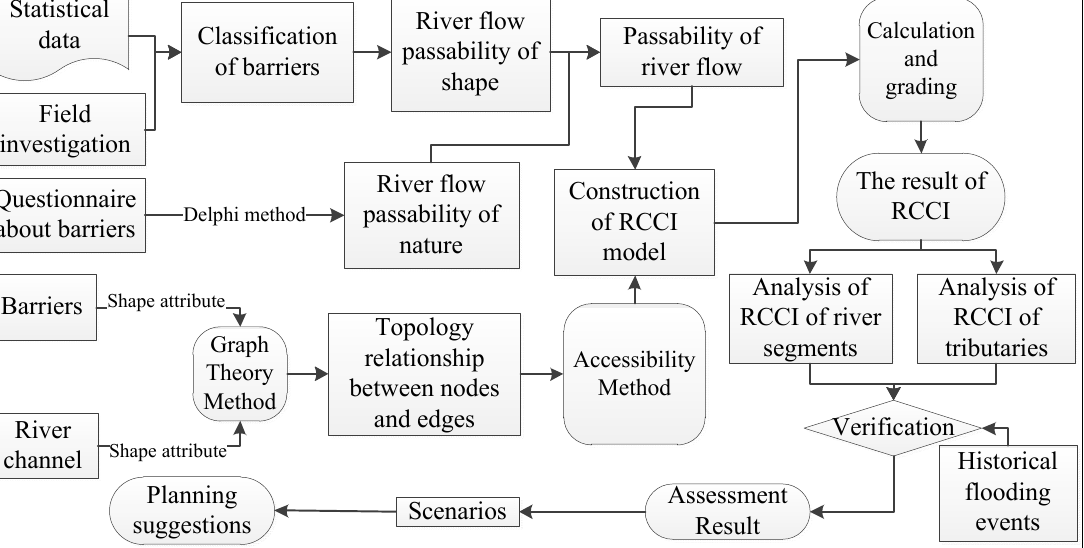
Table 1. Classification, grade, and blocking weight assignment of barriers.